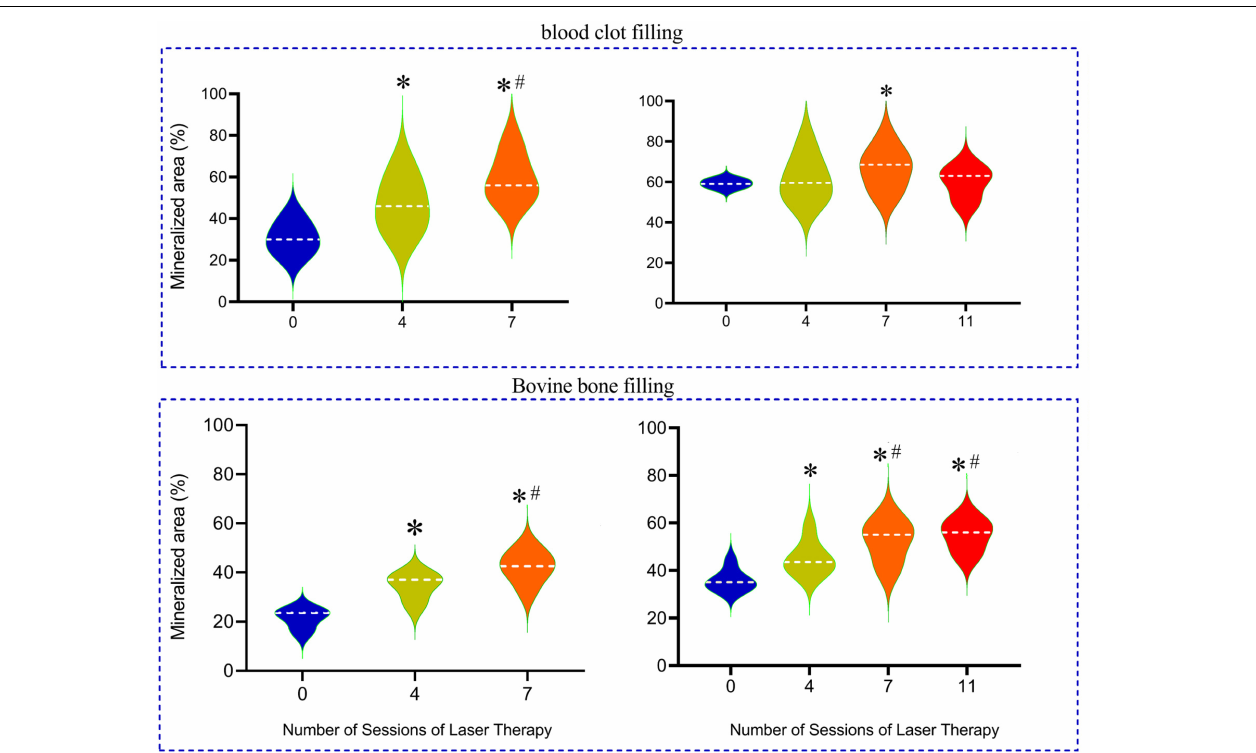
FIGURE 5 | Percentage of mineralized bone produced in the cavities that were filled with inorganic bovine bone (IBB) in comparison with blood clot-filled groups, mainly when associated with 4 to 11 sessions of LT and when compared with the non-irradiated group (0). The horizontal dashed line into the violin repress represents the mean values for each group. * p < 0.05 compared with the mean values of the Control group; # p < 0.05 compared with the 4 sessions group.